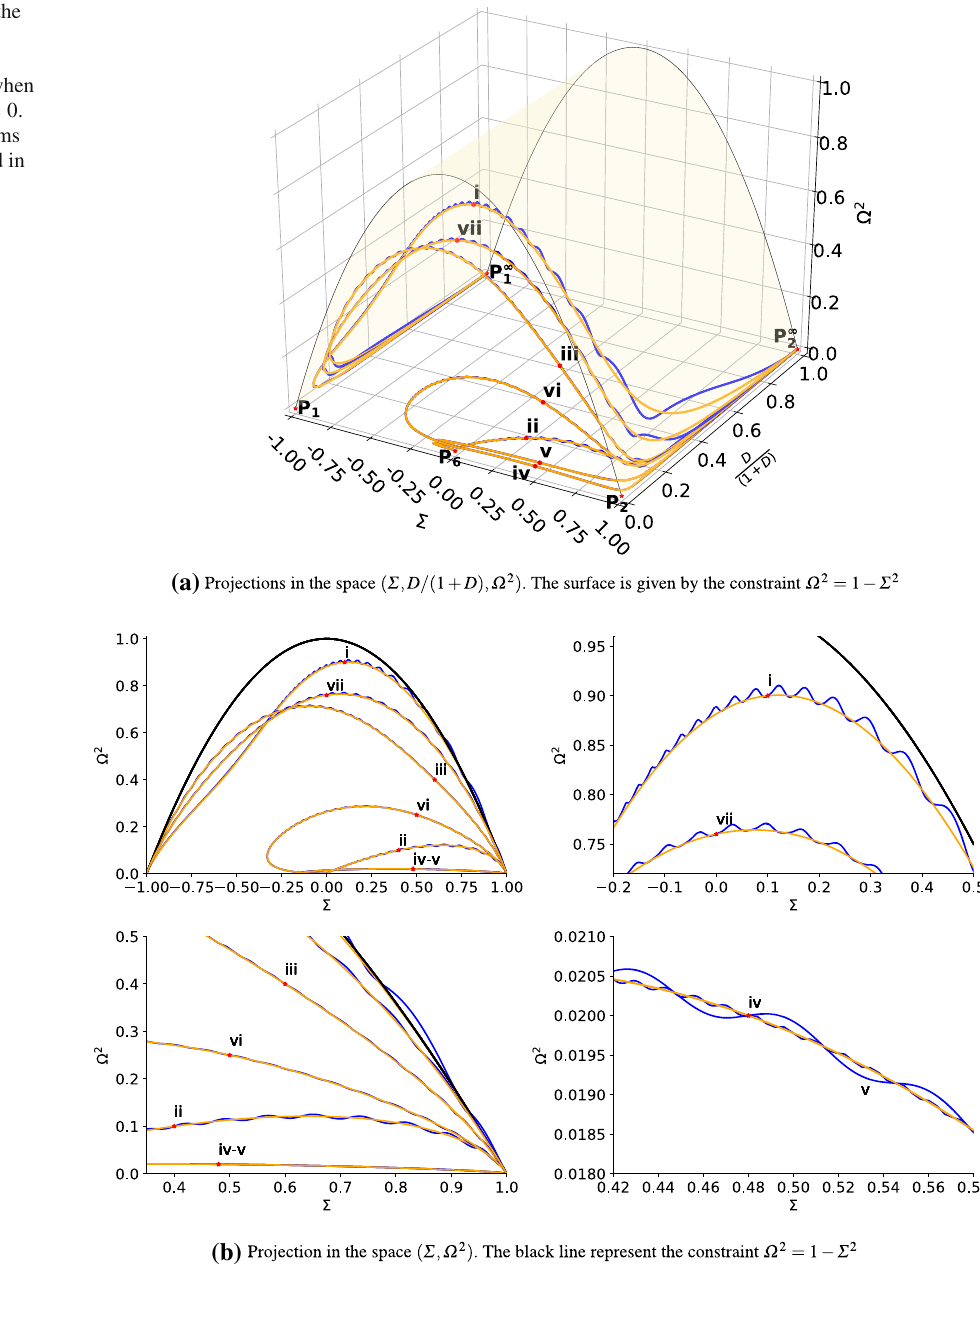
Figure 22a, b show solutions for a fluid corresponding to dust ( γ = 1). Figures 23a and 21b show solutions for a fluid corre- ). Figure 24a, b show solutions sponding to radiation ( γ = 4 3 for a fluid corresponding to stiff fluid ( γ = 2). Figures 21 and 25 show how solutions of full system (blue lines) follow the track of solutions of averaged system (orange lines) for the whole D -range. Figures 22, 23, 24, and 26 are evidence that main theorem presented in Sect. 4 is fulfilled for FLRW metric with positive curvature ( k = + 1) only when D is bounded. That is, solutions of full system (blue lines)